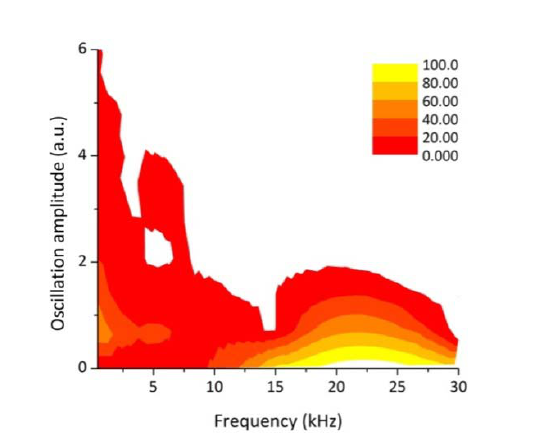
Figure 3. Relative amplitude of the oscillation frequency bands of the optical radiation emitted by the plasma plume during a welding process performed under optimal conditions (the color scale indicates the distribution in % for each frequency band).